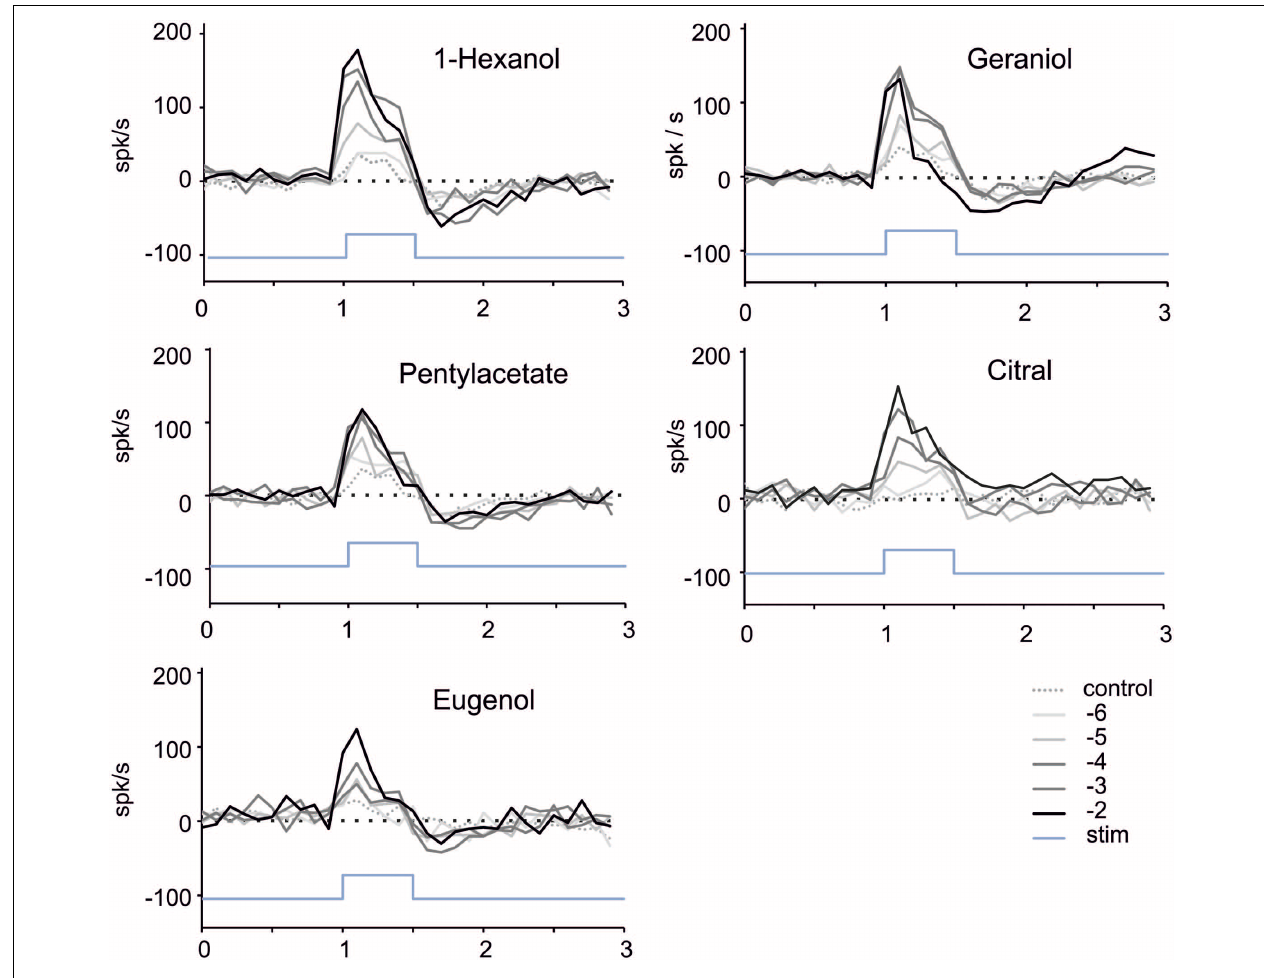
FIGURE 5 | Time course of the firing responses to stimulation. We computed the number of spikes occurring during consecutive 100ms bins ( n = 8–12 caterpillars, 1 stimulation per caterpillar for one dose of odorant). In order to reduce the dispersion of the curves due to inter-individual